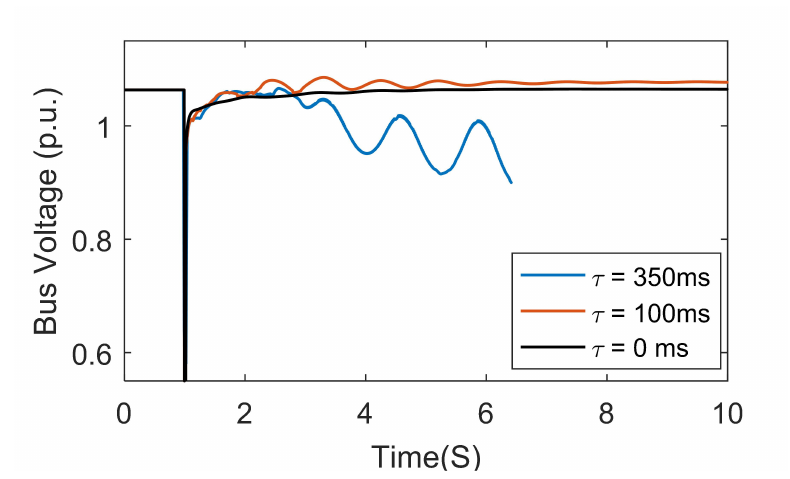
Figure 7. Bus 23 voltage magnitude with different timing attacks.